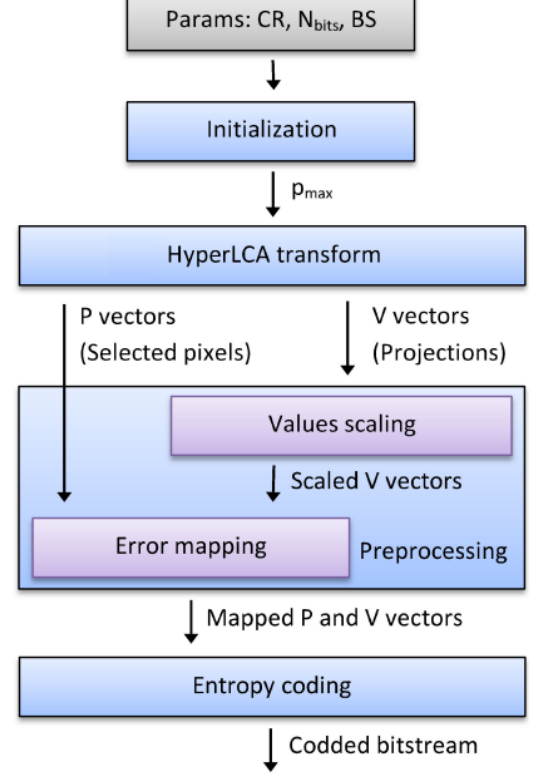
Figure 2. Flowchart of the HyperLCA